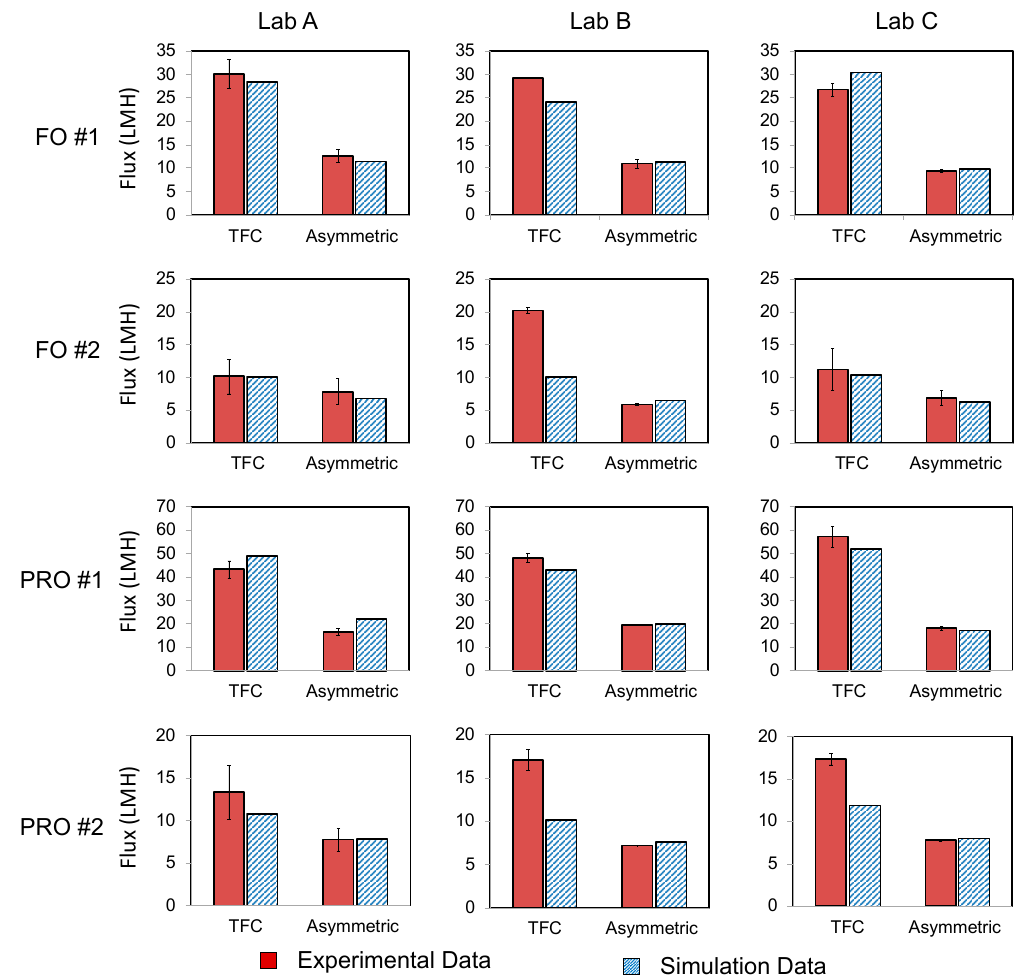
Figure 3. Comparison of water flux (L/m 2 /hr) from simulations and literature [4] conducted in FO and PRO modes (no hydraulic pressure). Labs A, B, and C were compared in the round-robin study [4]. In scenario #1, the feed was deionized water and the draw solution concentration was 1 M NaCl, while in #2 the feed concentration was 0.5 M NaCl and the draw solution concentration was 1.5 M NaCl.